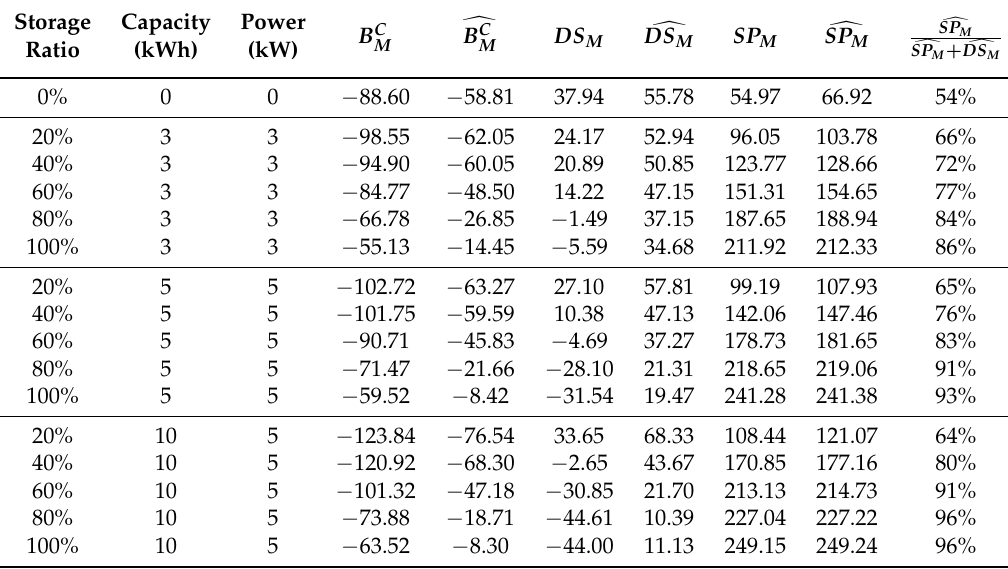
Table 5. Comparison between capped and uncapped results for the setting with imperfect predictions with storage for M in £. Both B C and (cid:100) B C are in a surplus states. However, increasing the storage ratio M M or the capacity decreases DS M until it becomes negative. The capped approach maintains a community surplus and results in higher (cid:100) DS M and (cid:100) SP M . The ratio of (cid:100) SP M in the benefits sum increase from 54% without storage to 66–96% with